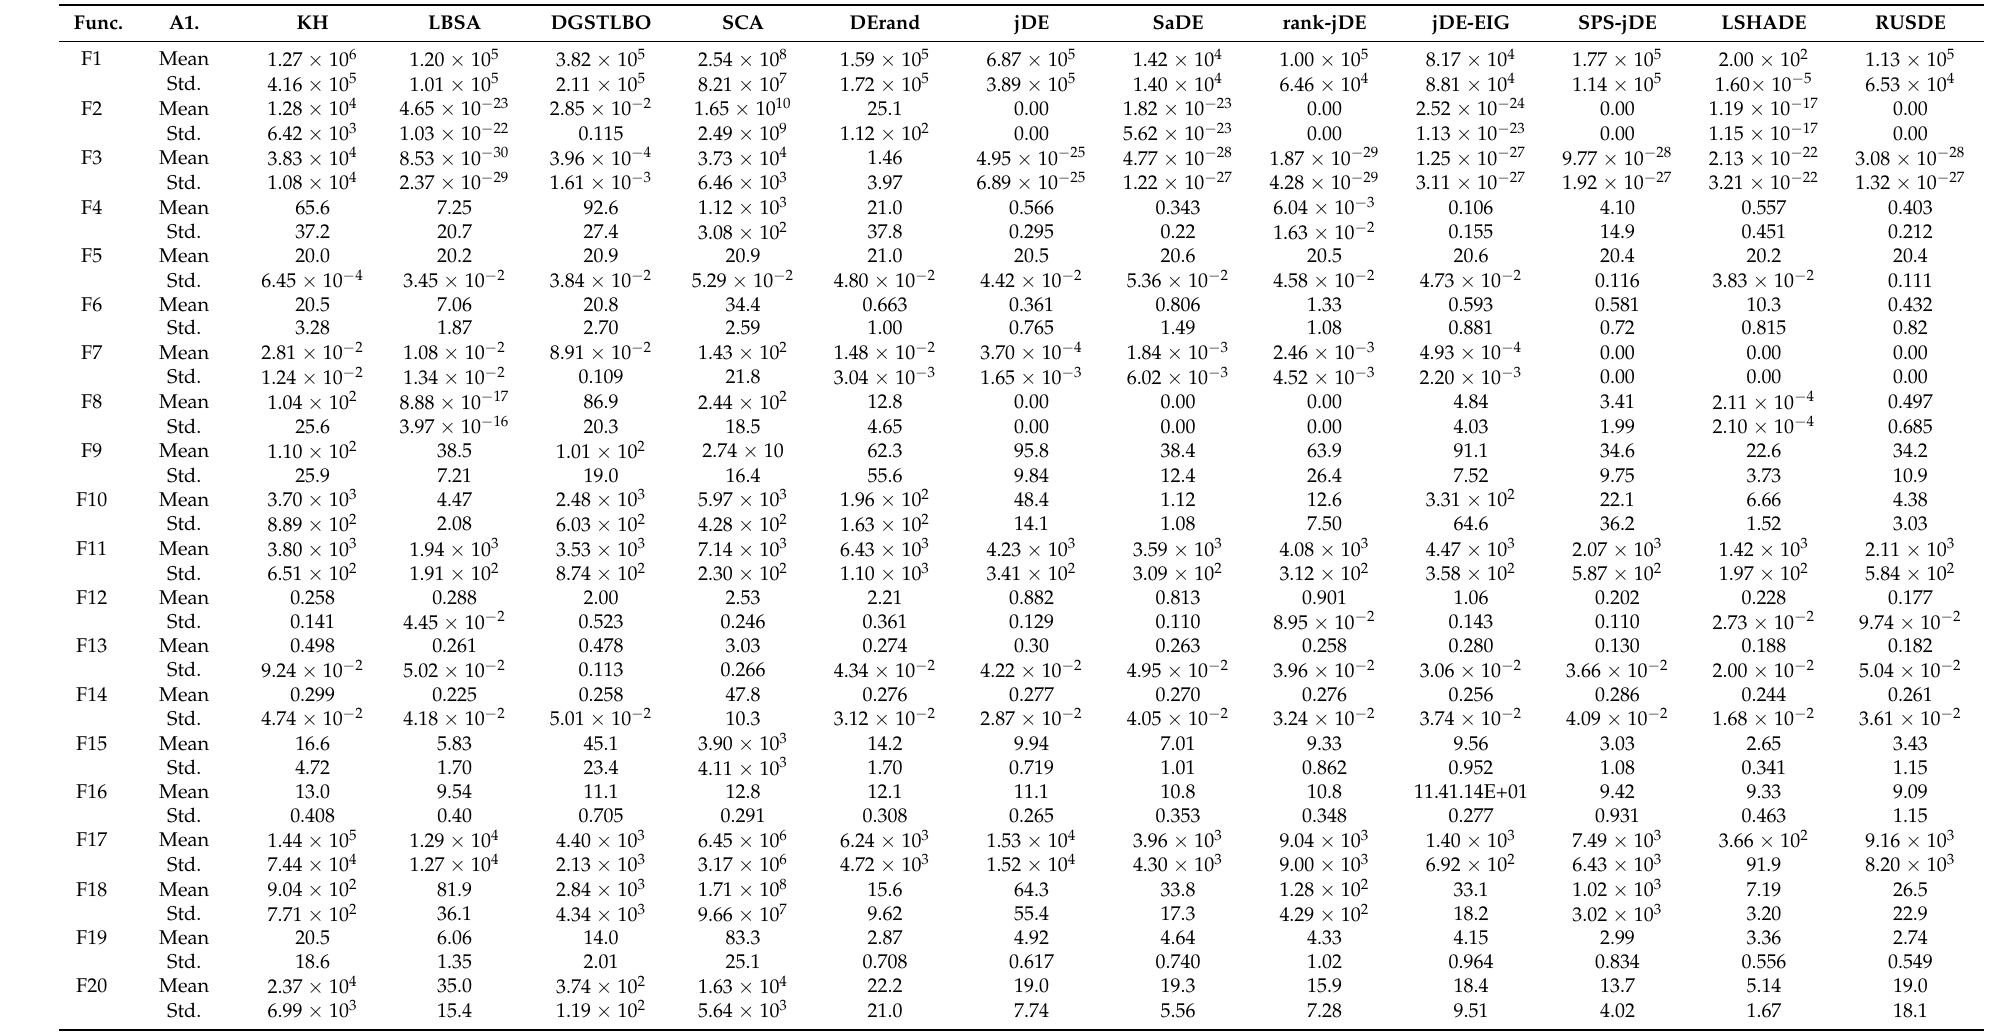
Table 2. The comparative results of 30-dimensional problems for CEC